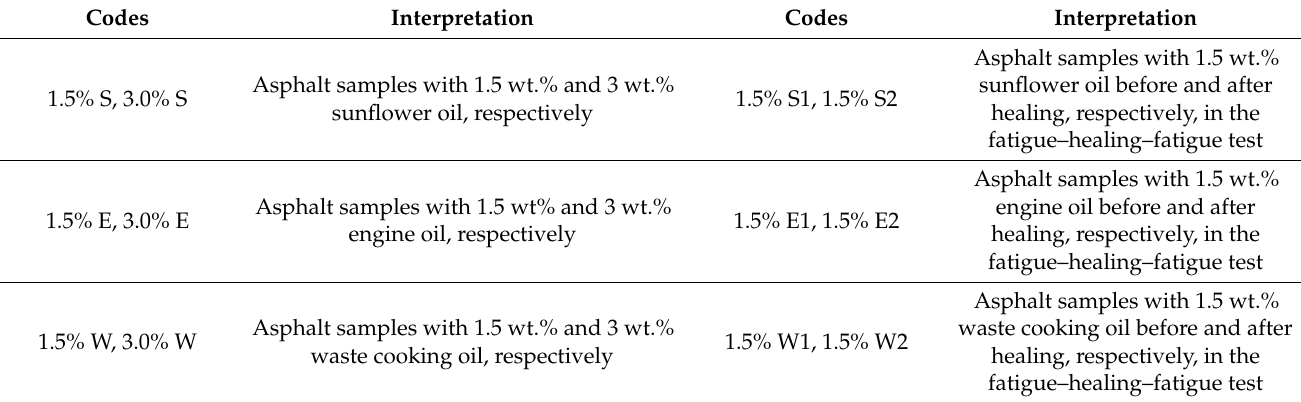
Table 1. Codes used in the manuscript and their